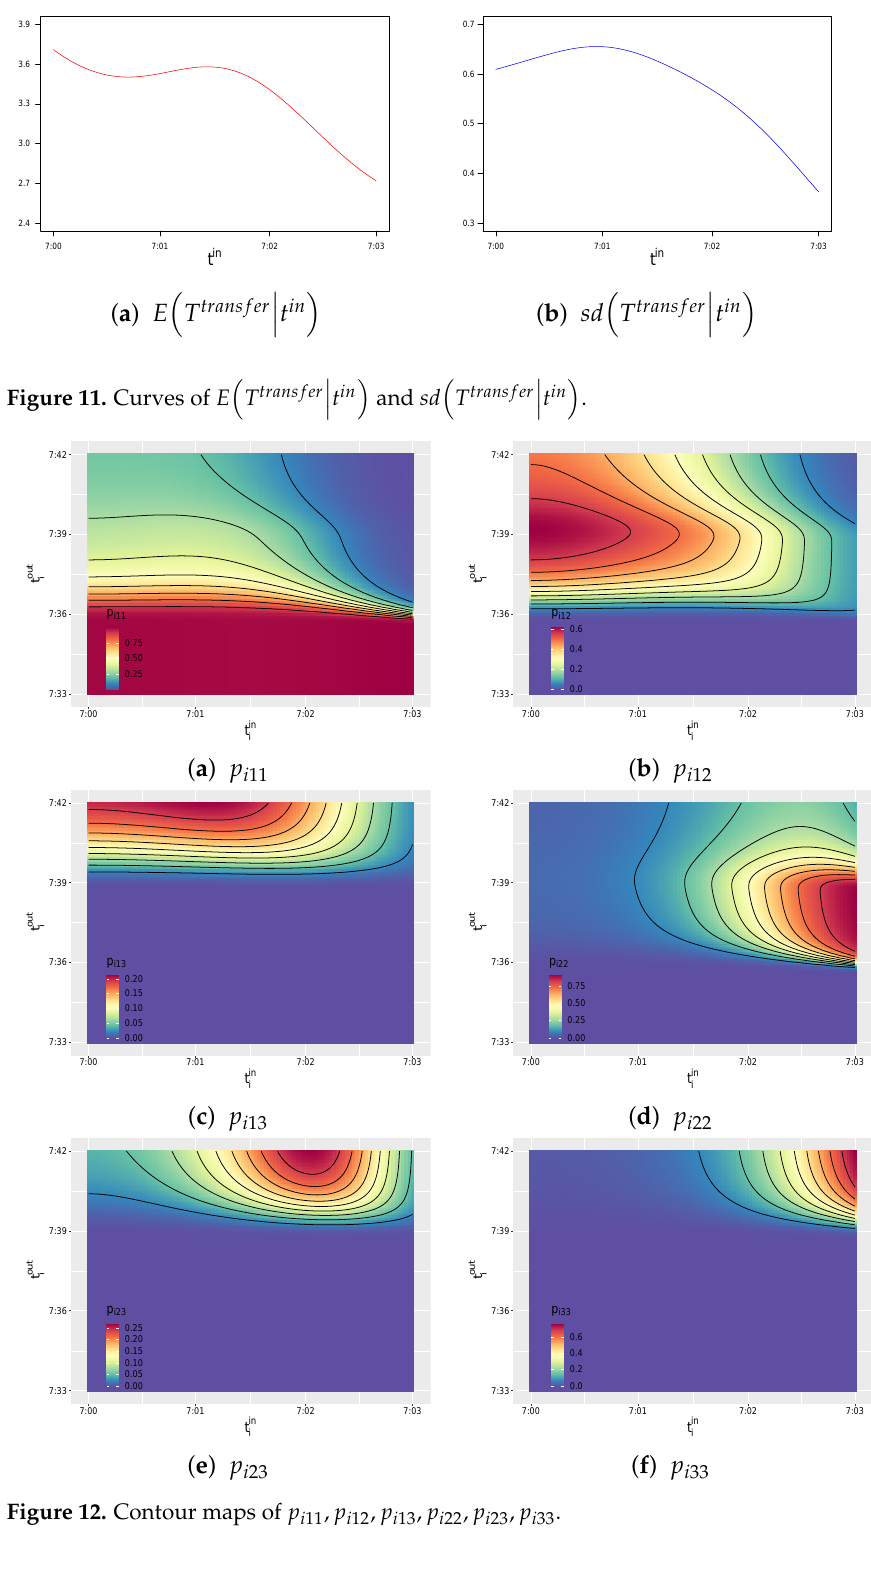
Figure 12. Contour maps of p i 11 , p i 12 , p i 13 , p i 22 , p i 23 , p i 33